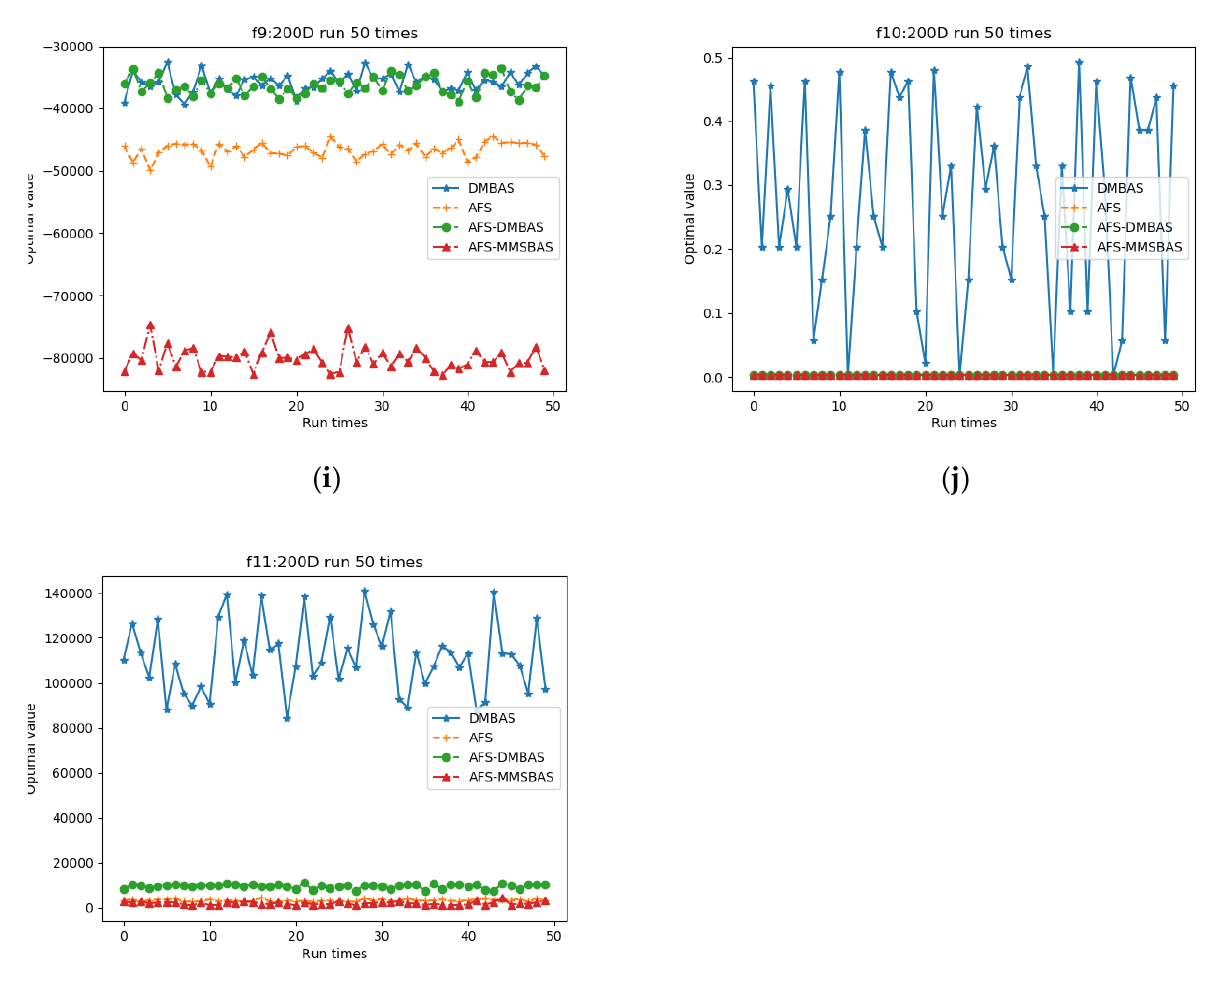
Figure 5. D = 200; comparison of stability of functions 𝑓 1 ~𝑓 11 . ( a ) Comparison of stability of four algorithms for function 𝑓 1 ; ( b ) Comparison of stability of four algorithms for function 𝑓 2 ; ( c ) Com- of four algorithms for function f 1 ; ( b ) Comparison of stability of four algorithms for function f 2 ; ( c ) Comparison of stability of four algorithms for function f 3 ; ( d ) Comparison of stability of four parison of stability of four algorithms for function 𝑓 3 ; ( d ) Comparison of stability of four algo- algorithms for function f 4 ; ( e ) Comparison of stability of four algorithms for function f 5 ; ( f ) Compari- rithms for function 𝑓 4 ; ( e ) Comparison of stability of four algorithms for function 𝑓 5 ; ( f ) Compari- son of stability of four algorithms for function f 6 ; ( g ) Comparison of stability of four algorithms for son of stability of four algorithms for function 𝑓 6 ; ( g ) Comparison of stability of four algorithms function f 7 ; ( h ) Comparison of stability of four algorithms for function f 8 ; ( i ) Comparison of stability for function 𝑓 7 ; ( h ) Comparison of stability of four algorithms for function 𝑓 8 ; ( i ) Comparison of of four algorithms for function f 9 ; ( j ) Comparison of stability of four algorithms for function f 10 ; stability of four algorithms for function 𝑓 9 ; ( j ) Comparison of stability of four algorithms for func- ( k ) Comparison of stability of four algorithms for function f 11 tion 𝑓 10 ; ( k ) Comparison of stability of four algorithms for function 𝑓 11 .